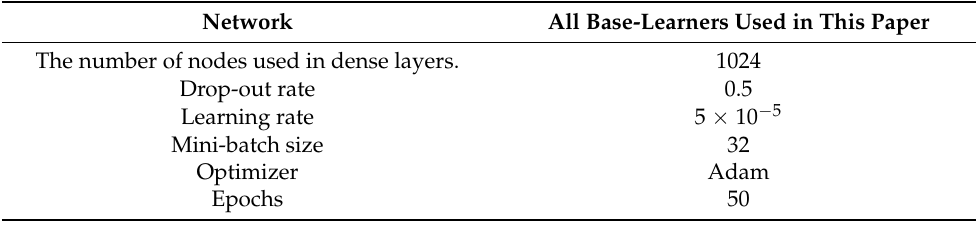
Table 4. The hyper-parameters that were used for all Base-Learners. Network All Base-Learners Used in This Paper The number of nodes used in dense